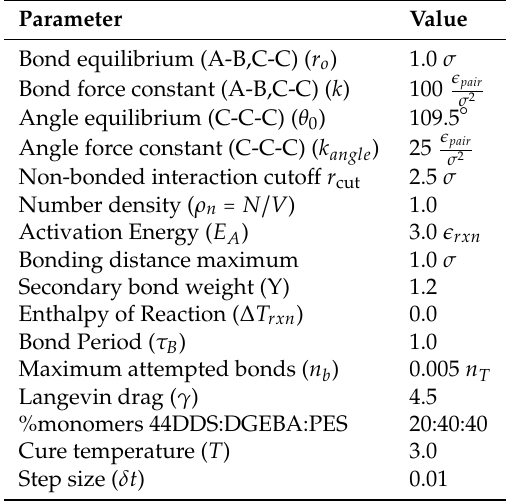
Table 2. Fiducial simulation parameters. Note that in the present CG model, monomer% and volume% are equivalent but are not identical to corresponding experimental